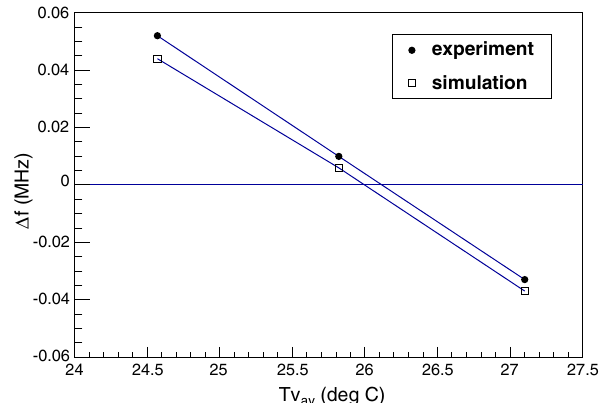
FIG. 9. Frequency response as a function of temperature of vane water. The vertical axis indicates the frequency shift from the rf-off state.